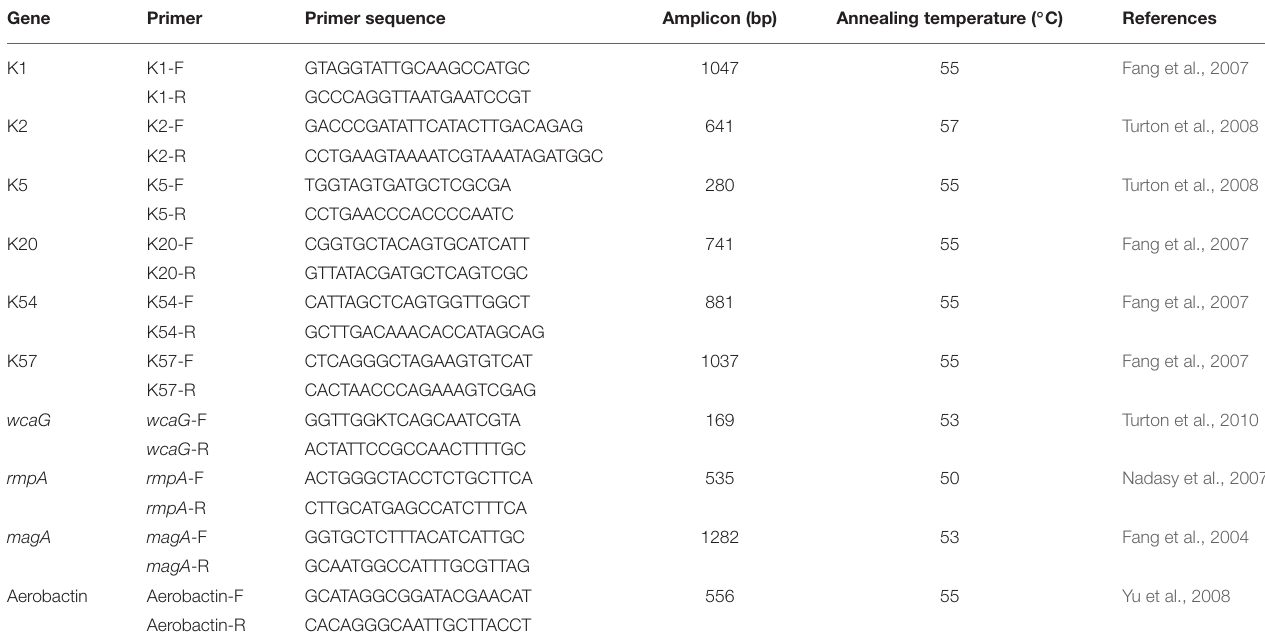
TABLE 1 | List of primers for detection of Klebsiella pneumoniae virulence